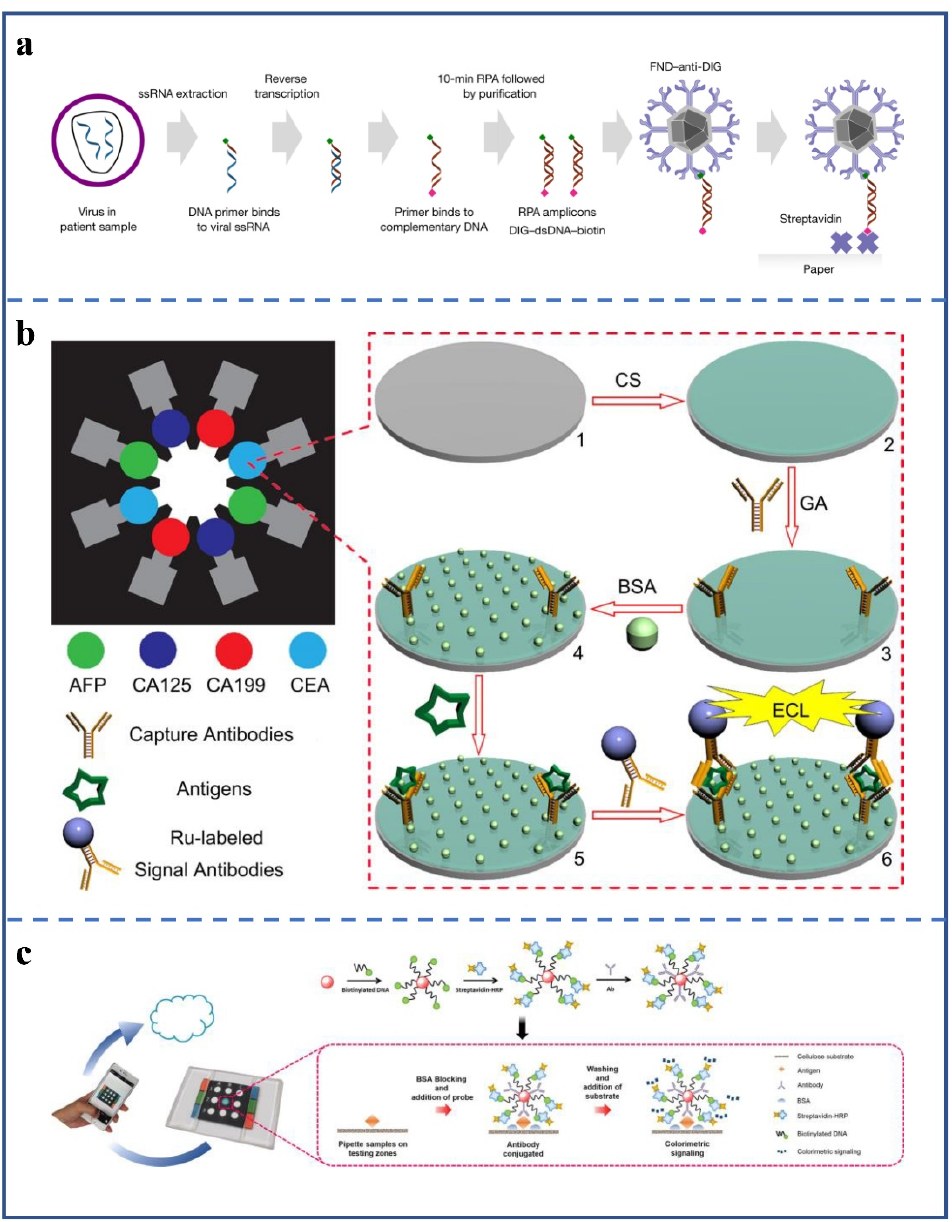
Figure 7. ( a ) Schematic of the detection principle [135]. Viral RNA is amplified using primers modified with DIG and biotin, respectively. One end of the amplicon is bound to the FND surface antibody and the other end to streptavidin on the test strip, forming a sandwich structure when positive samples are detected. (Copyright © 2022, The Author(s), under exclusive license to Springer Nature Limited). ( b ) Schematic representation of the fabrication and assay procedure for a 3D paper- based ECL device [50]. (1) screen-printed carbon working electrode; (2) after chitosan modification; (3) after immobilization of capture antibodies; (4) after blocking and washing; (5) after capturing and washing; (6) after incubation with signal antibodies, washing, and triggering ECL reaction. (Copyright © 2022 Elsevier Ltd. All rights reserved). ( c ) Schematic diagram of paper-based detection using a functionalized gold nanoprobe sensing strategy [137]. The preparation principle of the probe and the detection process of the method. The results can be identified and uploaded via a smartphone. (Copyright © 2022, American Chemical